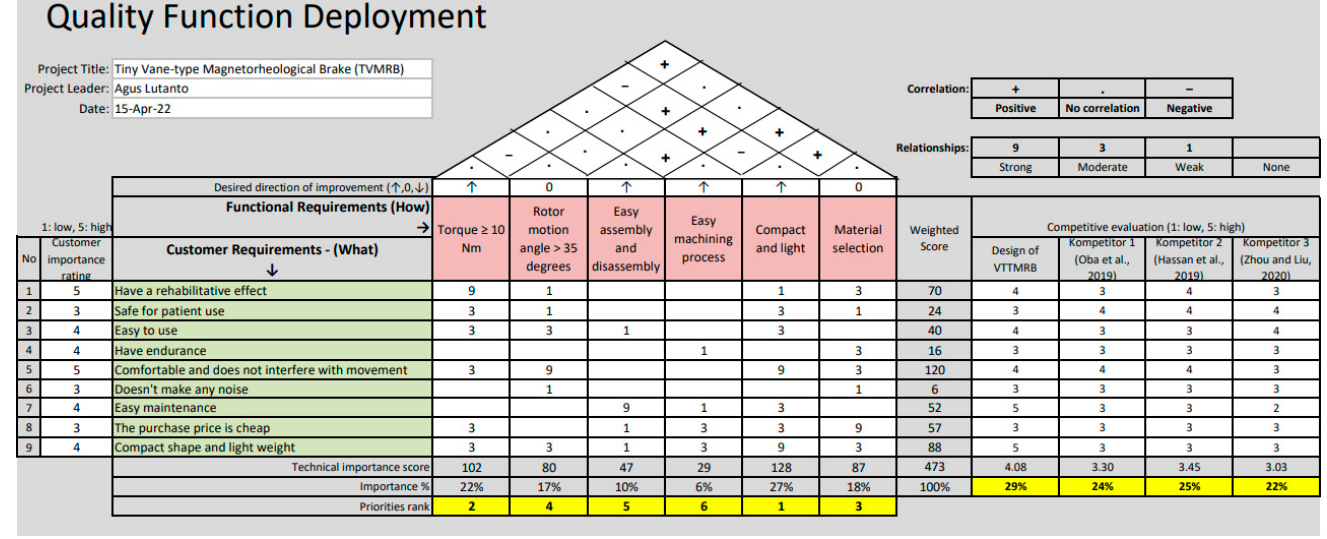
Figure 18. HOQ of the TVMRB